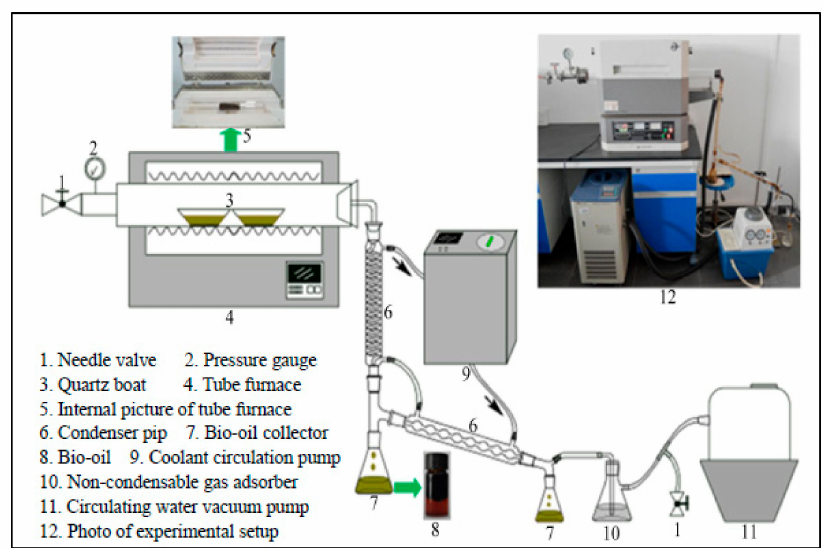
Figure 2. Schematic diagram of two-stage